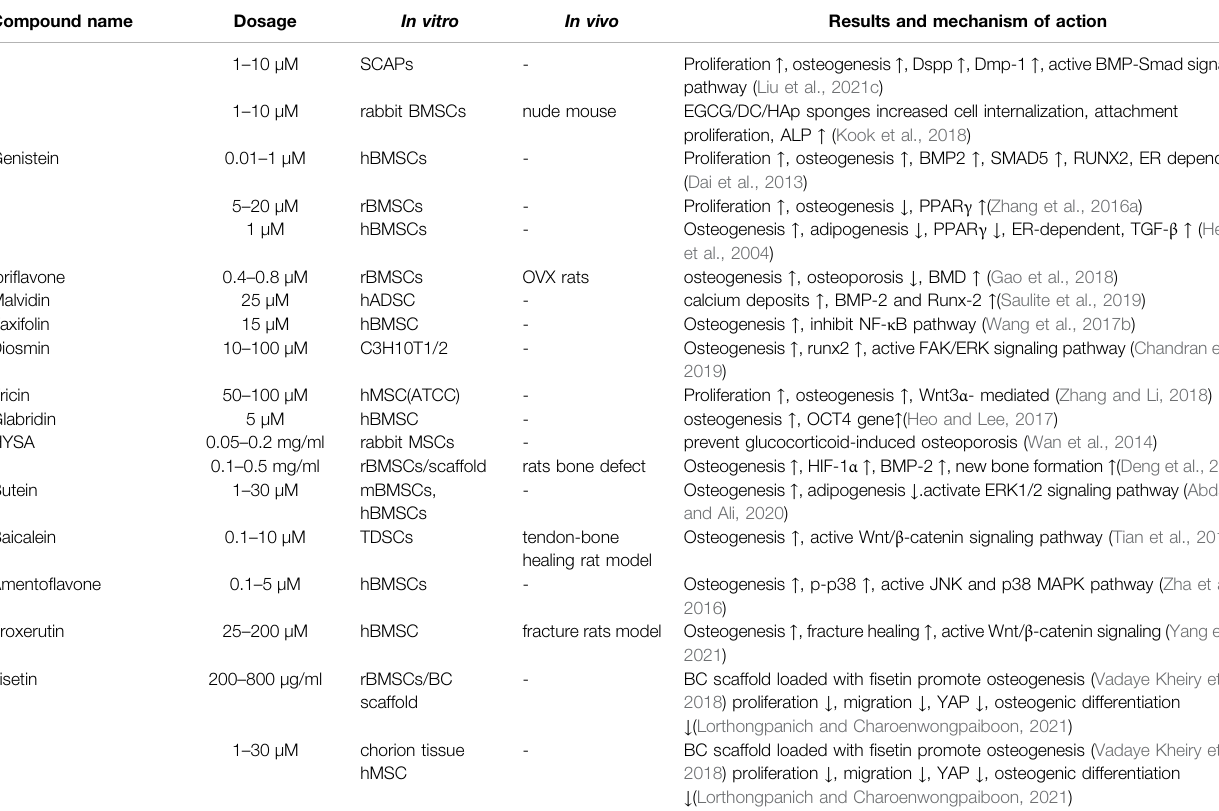
TABLE 2 | ( Continued ) The list of some fl avonoids compounds on MSCs osteogenic differentiation.